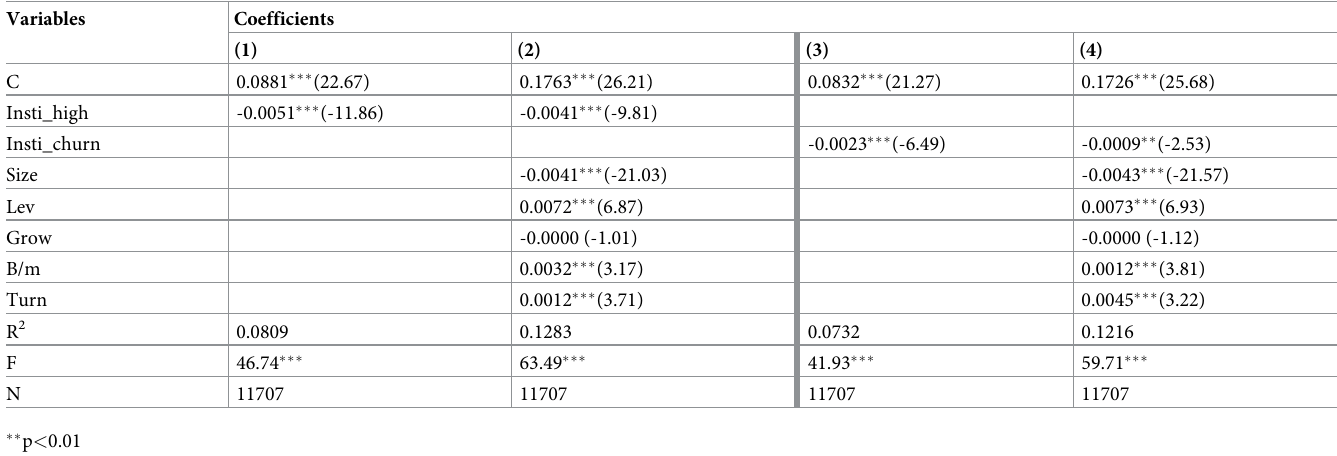
Table 5. The robustness test